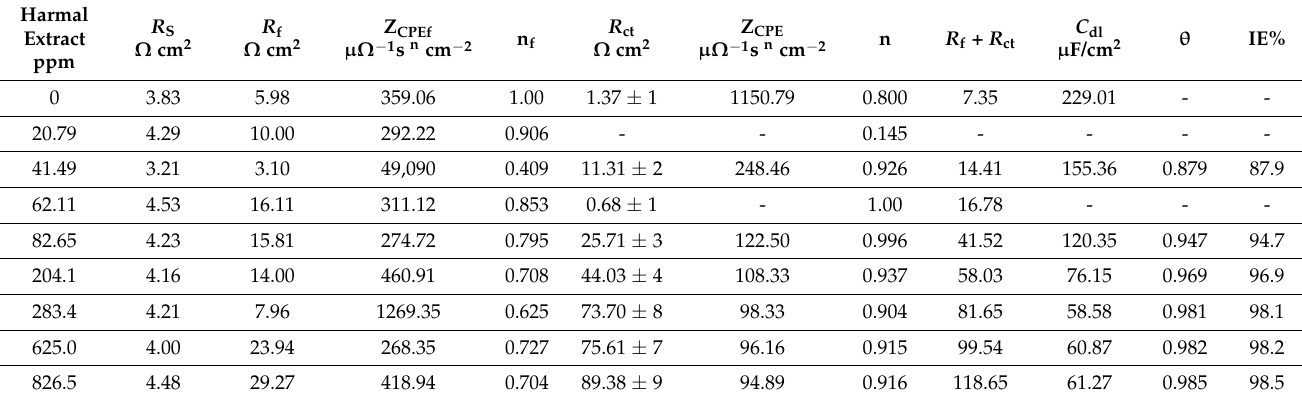
Table 2. Impedance parameters for Harmal extract on C-steel in 0.25 M H 2 SO 4 medium by fitting the equivalent circuit model